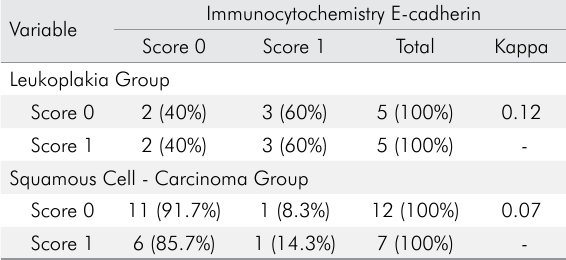
Table 3. Level of agreement between immunocytochemical and immunohistochemical expression of involucrin in the leukoplakia and oral squamous cell carcinoma